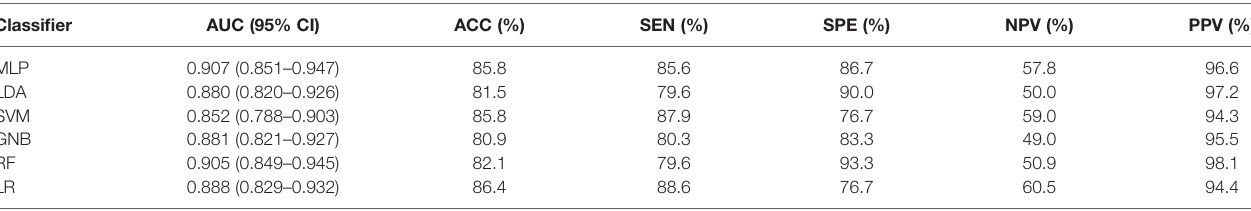
TABLE 6 | Performances of the six machine learning classi fi ers for predicting AR expression. Classi fi